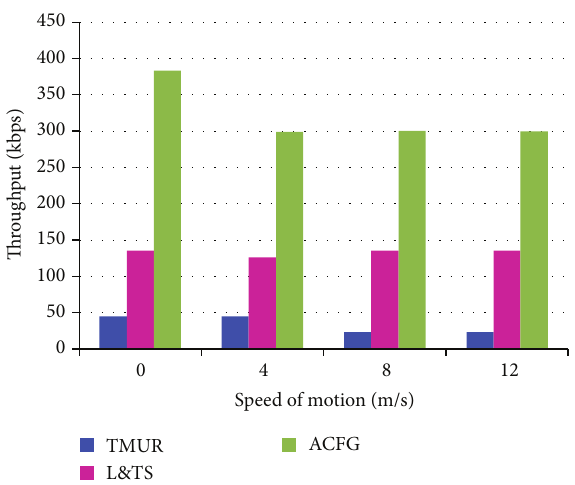
Figure 19: Throughput against node mobility.